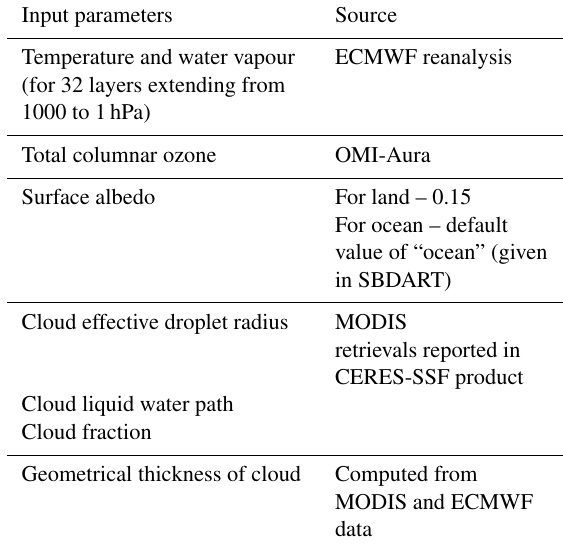
Table 1. The list of parameters and their sources used as an input to the SDBART model for the simulation of RF aci